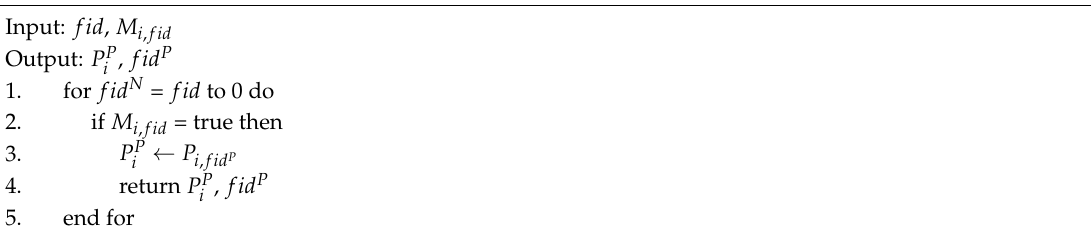
Algorithm 9 Fall detection for a missing person